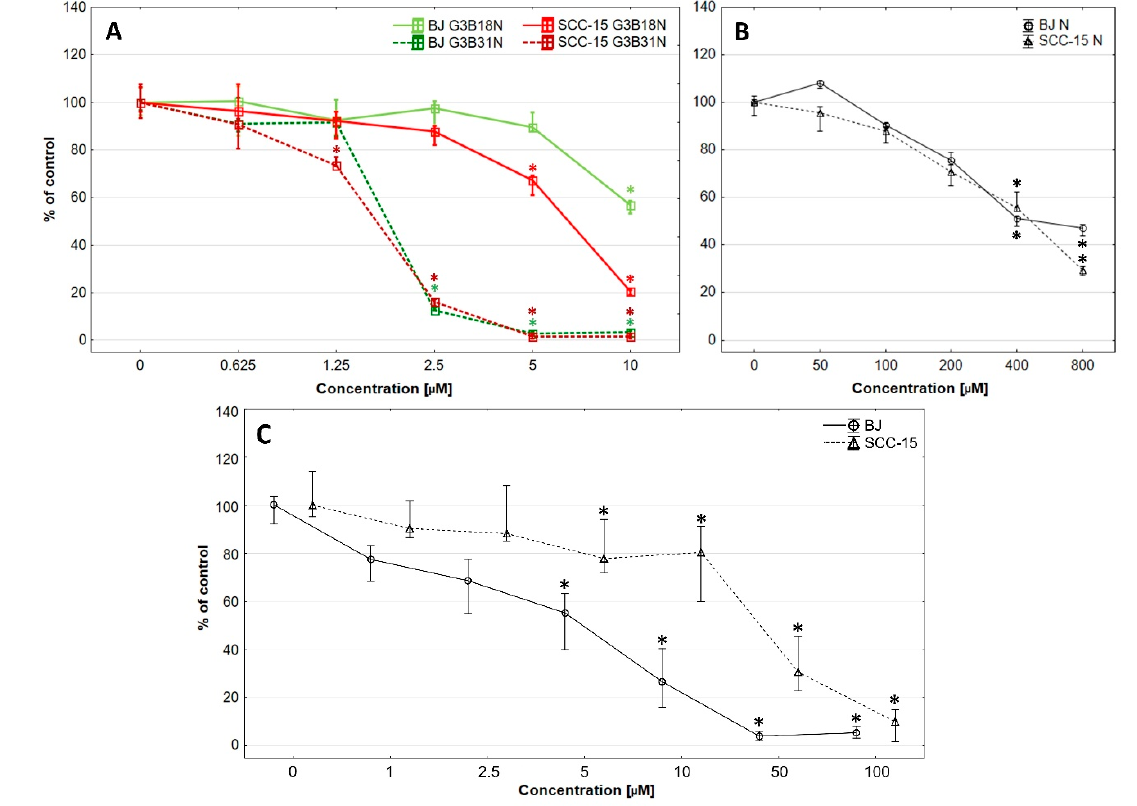
Figure 2. Cytotoxicity of G3 B18N and G3 B31N ( A ), nimesulide alone ( B ), or native PAMAM G3 dendrimer ( C ) against BJ and SCC-15 cells after 24 h incubation, expressed as percent of control. Results are expressed as percentage of non-treated control. Squares show medians and whiskers are lower and upper quartile. * p < 0.05 significant difference against control estimated with Kruskal-Wallis test.